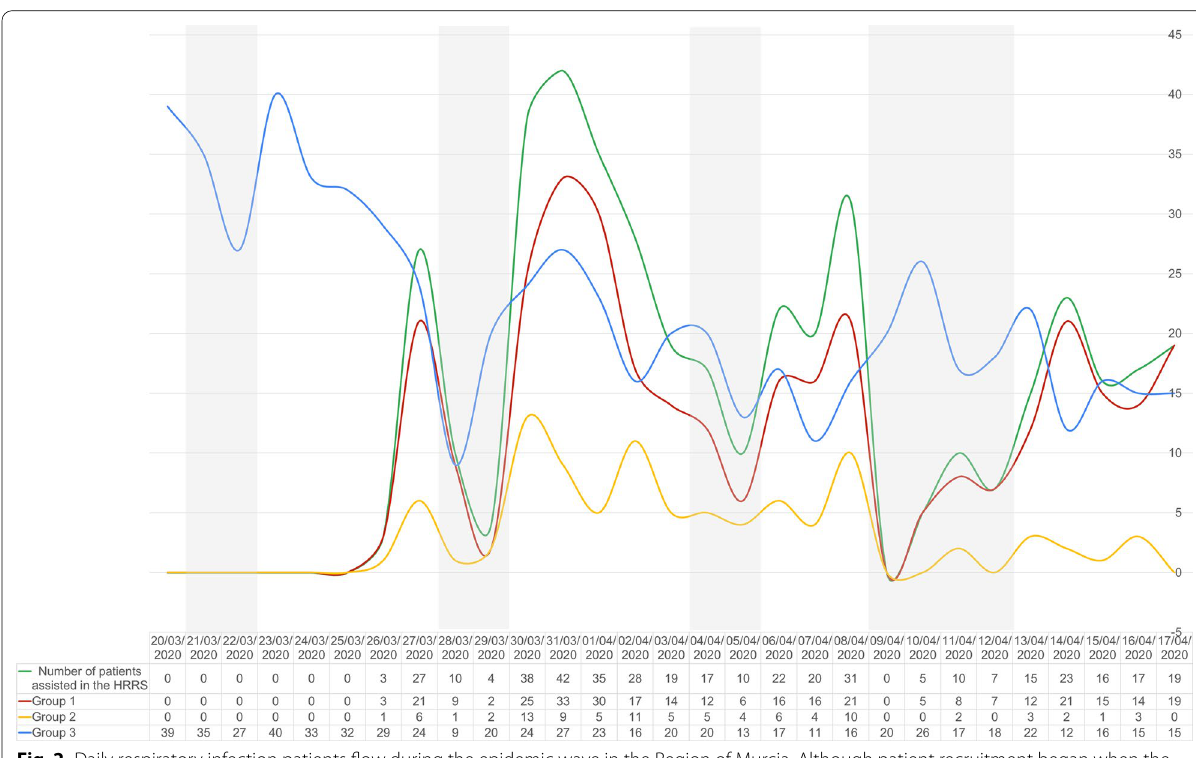
Fig. 2 Daily respiratory infection patients flow during the epidemic wave in the Region of Murcia. Although patient recruitment began when the pcHRRS started on March 26, we show the number of patients seen in the emergency department (group 3) since March 20, so that the impact of the pcHRRS by decreasing the number of group 3 patients can be appreciated. (a) All primary care high-resolution radiology service (pcHRRS) patients (green line); (b) pcHRRS discharged patients (group 1, red line); (c) pcHRRS patients referred to the emergency department (ED) (group 2, yellow line); (d) patients arriving to the ED by themselves (group 3, blue line). Grey bands correspond to weekends and holidays. Patients seen within the pcHRRS (green line) exceeded the number of patients arriving to the ED (blue line) in the study window, except for holidays, when, despite being operational, patients were less referred to pcHRRS. Most patients seen at the pcHRRS went back home (red